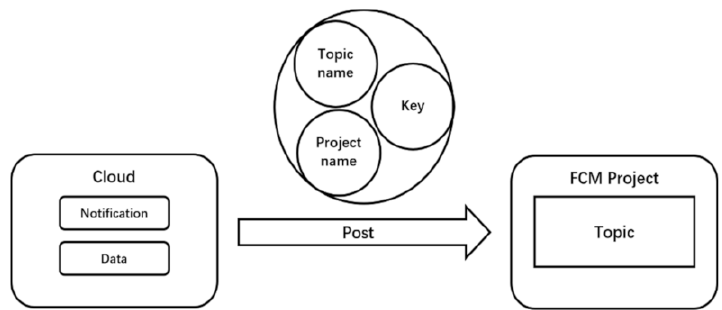
Figure 3. Server connection